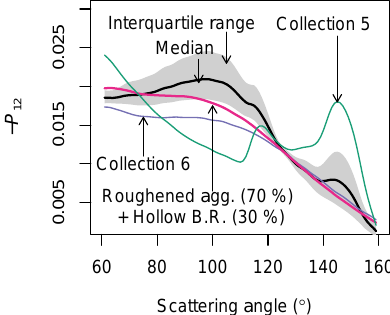
Figure 18. Comparison of inferred − P 12 and the counterparts used in MODIS Collections 5 and 6. The − P 12 of MODIS Collection 6 (blue line) is more consistent with the reconstructed − P 12 (black thick line) than the − P 12 of MODIS Collection 5 (green line). How- ever, better consistency is obtained with a two-habit model (thick magenta line), by increasing the roughness to σ 2 = 0 . 8 and adding 30% of hollow bullet rosette